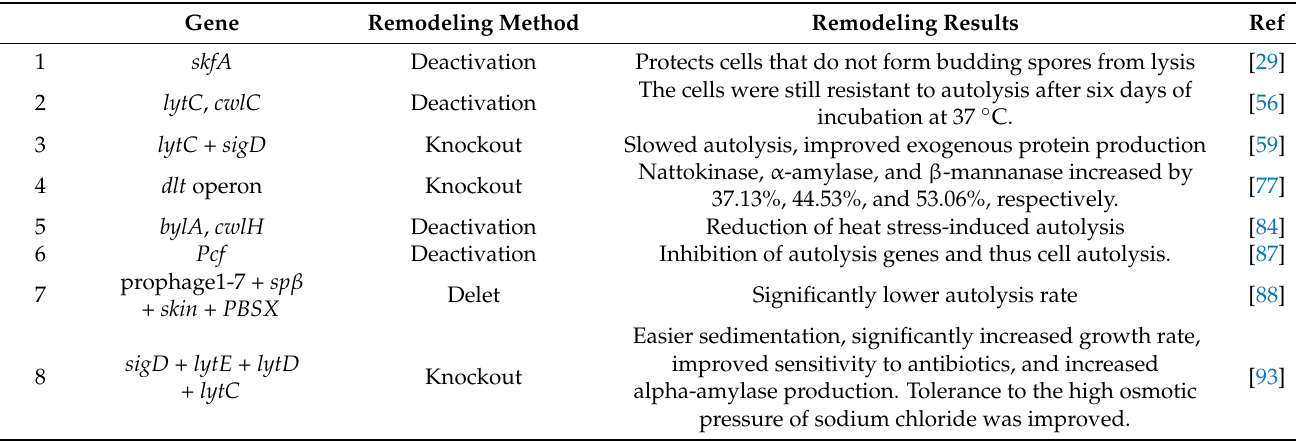
Table 2. Strategies and results of the modification of autolysis